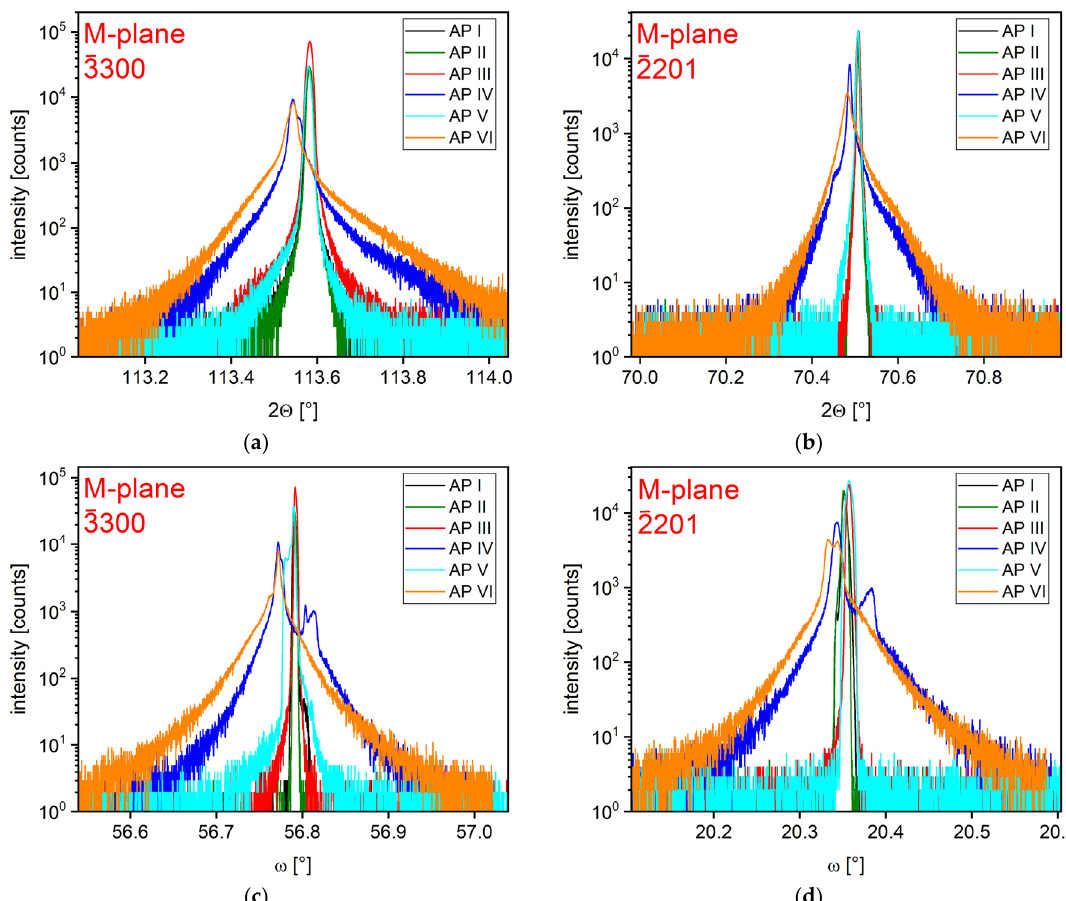
(cid:0) (cid:1) 1100 slice: ( a ) 2 θ / θ -scan for reflection 3300,